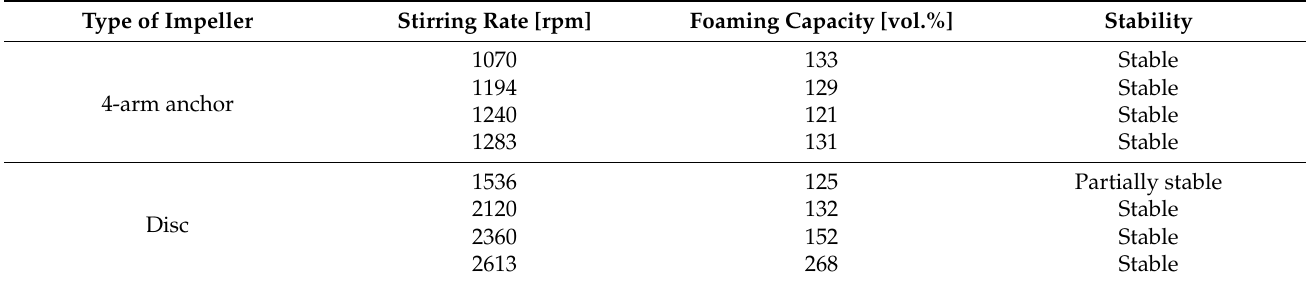
Table 2. Influence of the type of impeller and stirring rate on the foaming capacity and stability of the foams prepared with a load of 37 vol.% MgAl 2 O 4 and stirring for 2 min. Type of